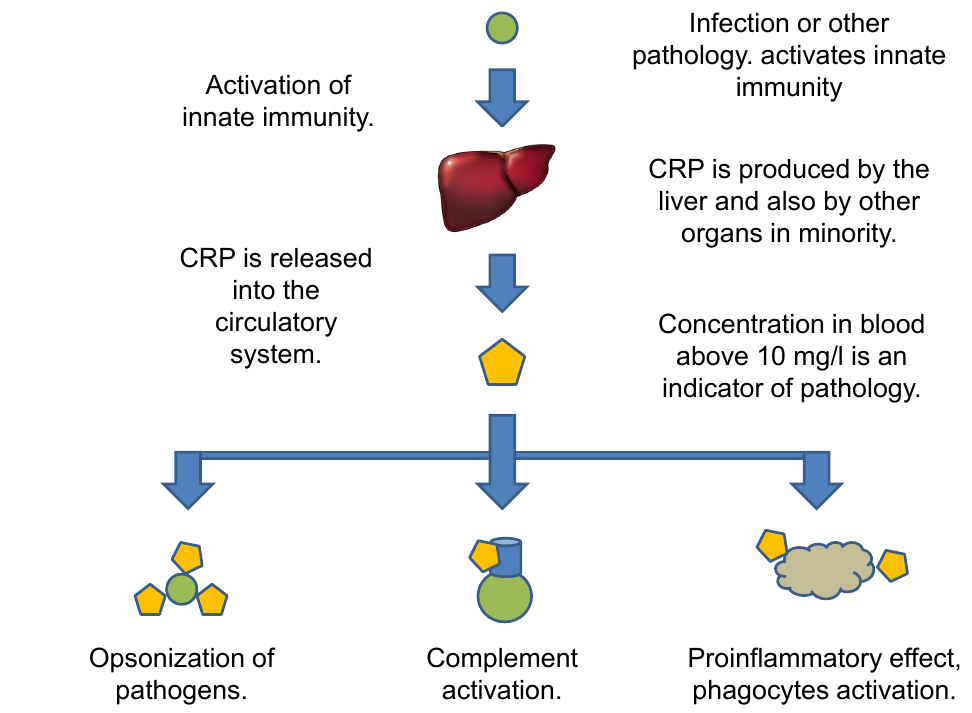
Figure 2. Survey of CRP pathway and initiated effects.